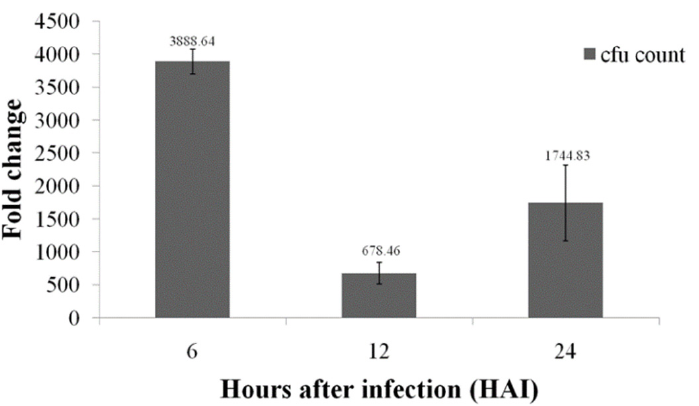
Figure 8. Population dynamics of endophyte ( P. aeruginosa PM389) on challenge inoculation in Triticum aestivum (var. GW322) at transcript level. Each value represents mean of duplicates and vertical bars represent standard deviation. The mean values were compared using Duncan’s multiple range test (DMRT) at p < 0.05. Values that were significantly different from each other are headed by different letters in each bar of treatment.